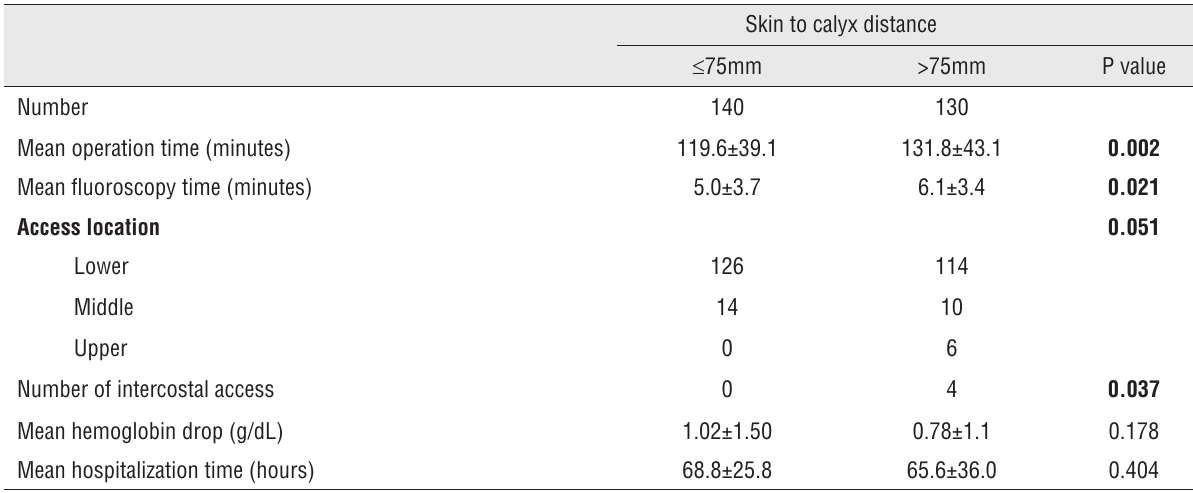
Table 2 - comparison of perioperative